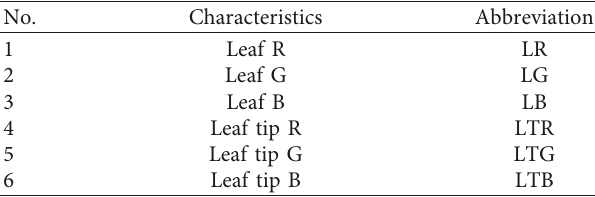
Table 1: Leaf color characteristics for identification of nutrition deficiency.